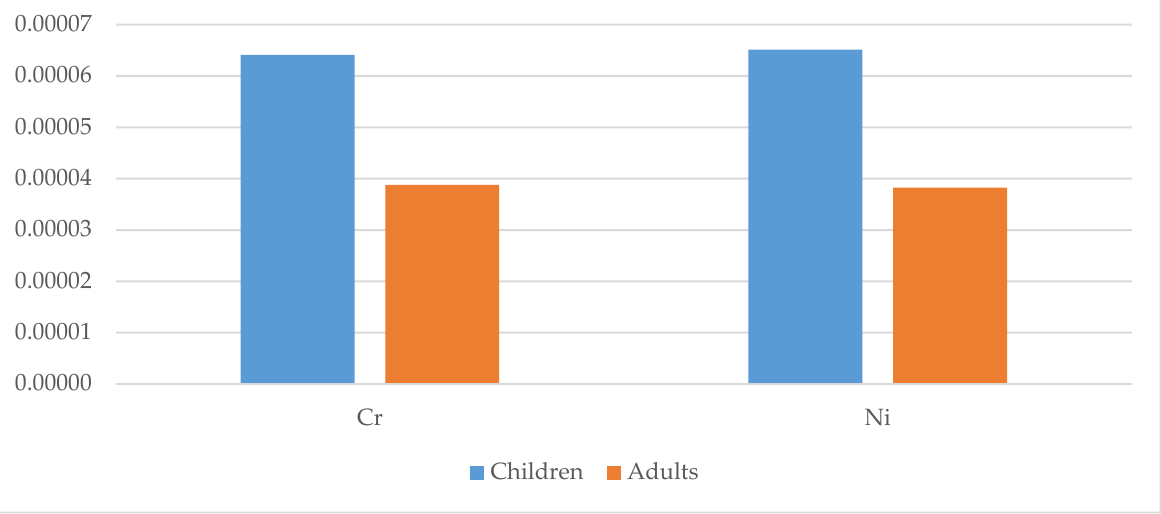
Figure 15. Total carcinogenic risk (TCR) for children and adults for selected metals in the studied geophagic clays in Cam- eroon.